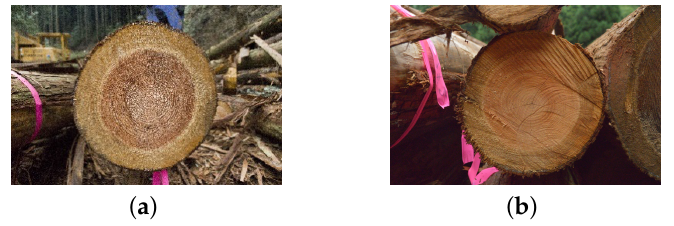
Figure 9. The outdoor wood images. ( a ) An image of an unprocessed low-noise log. ( b ) An image of an unprocessed high-noise